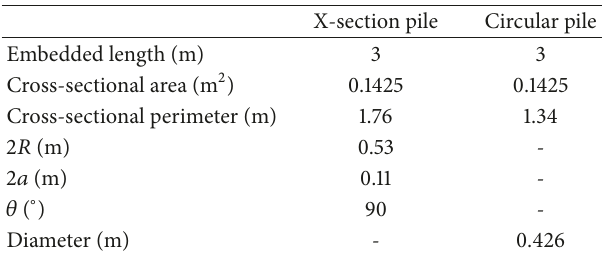
Table 1: Dimensions of test